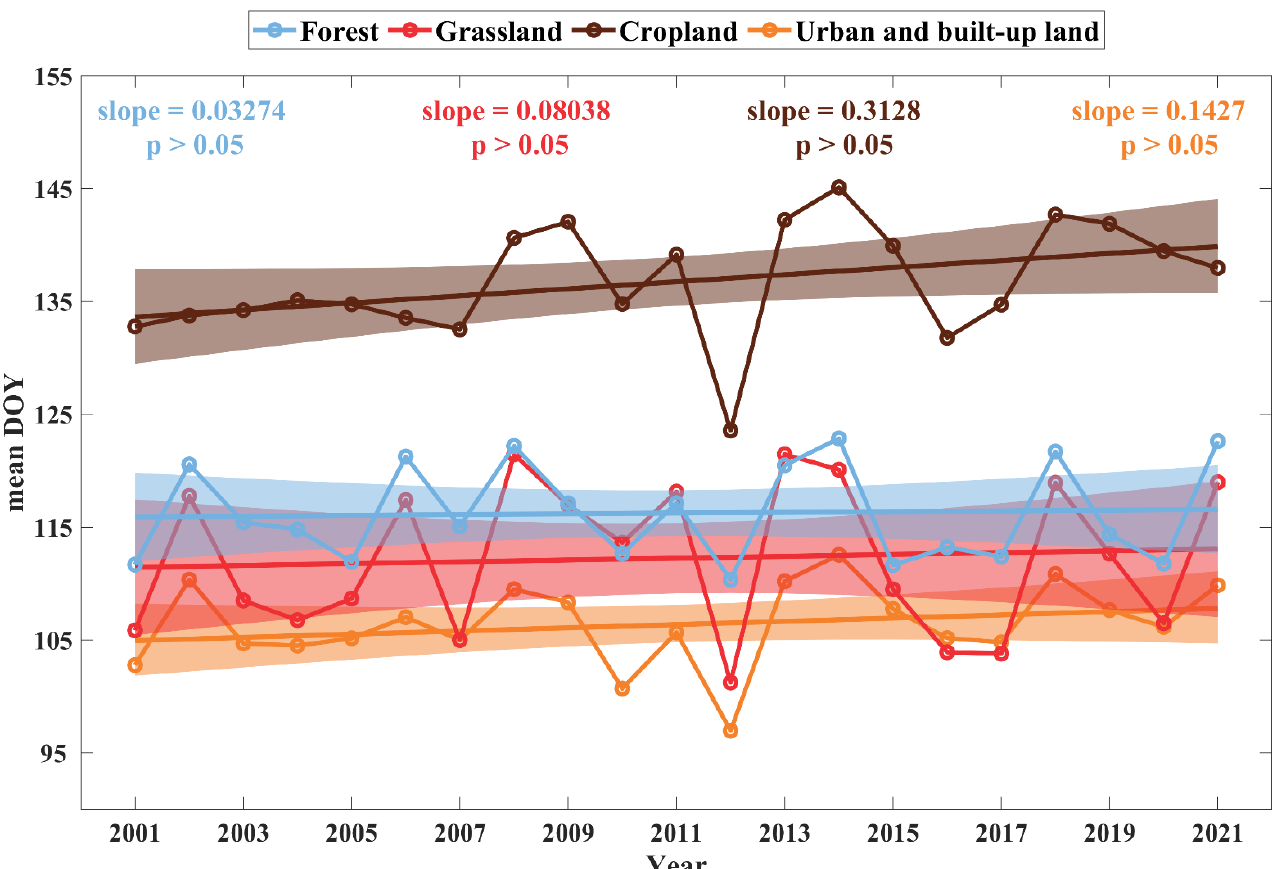
Figure 7. Temporal trends of annual mean SOS for different land cover types (i.e., forest, grassland, cropland, and urban and built-up land) in the conterminous United States over the past two decades. The colored solid lines denote the trend lines, and the colored bars represent 95% confidence intervals.